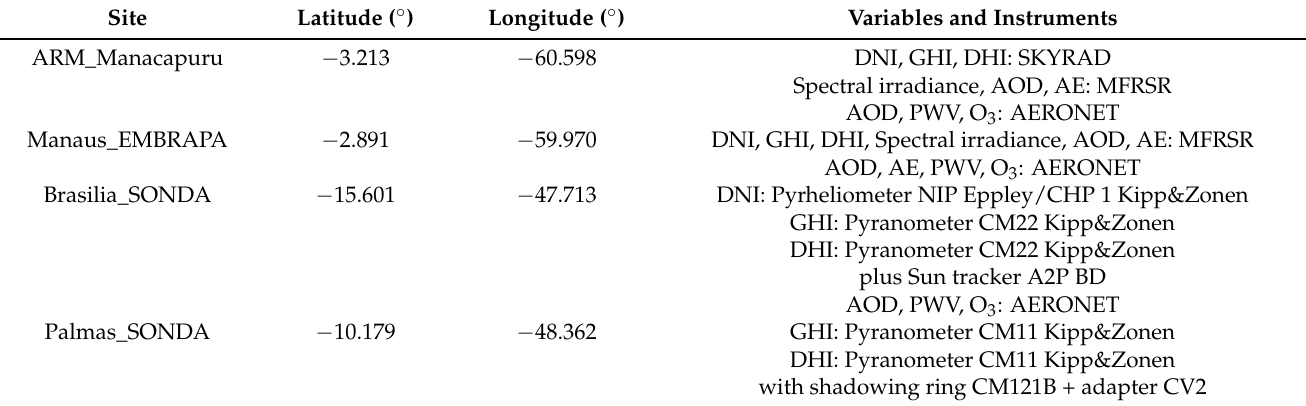
Table 1. List of observational data at the four ground measurement sites. First two lines describe the sites located in Brazilian Amazon and the last two are installed in the Cerrado (Brazilian central region). Site Latitude ( ◦ ) Longitude ( ◦ ) Variables and Instruments